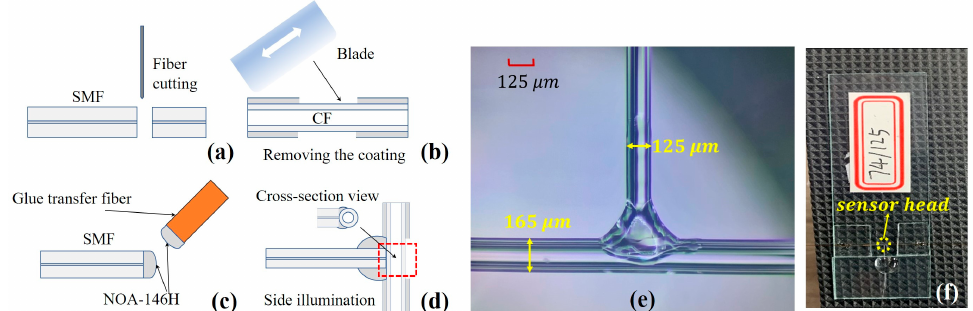
Figure 2. ( a – d ) Steps of the sensor fabrication process; ( e ) The microscope image of the fabricated sensor head; ( f ) The sensor fixed on the glass slide.